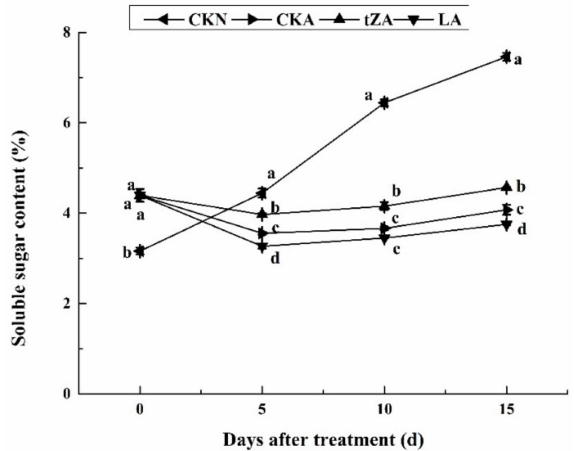
Figure 2. The graph representing changes in soluble sugar content in CKN, CKA, tZA and LA groups after treatment. CKN: the group of normal seeds with clean water treatment; CKA: the group of small aborted seeds with clean water treatment; tZA and LA: the group of small aborted seeds treated with trans-zeatin and lovastatin treatment, respectively. Different lower-case letters among different treatment groups indicate significant differences based on one-way analysis of variance in SPSS 21.0 followed by the Duncan’s test ( p <